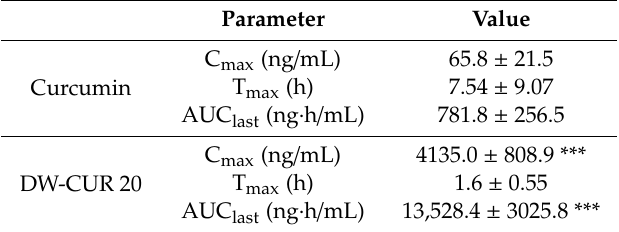
Figure 3. Plasma concentration–time profile of curcumin after oral administration of curcumin (50 mg / kg) and DW-CUR 20 curcumin (250 mg / kg; 50 mg / kg as curcumin) to rats ( n = 5). Data are expressed as mean ± SD. Table 1. Pharmacokinetic parameters for curcumin and DW-CUR